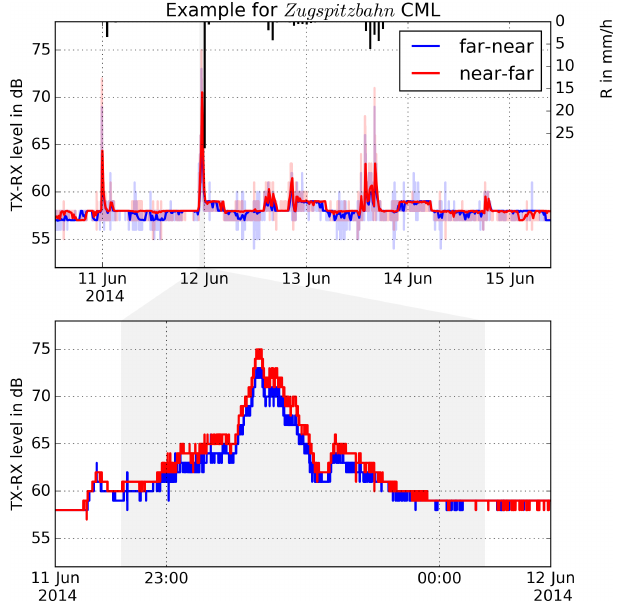
Figure 4. Example data record of a Ceragon IPMax CML used for the intranet connection between summit and valley stations of an alpine ski resort. The CML has a length of 4.7km and uses frequen- cies of 22.022 and 23.033GHz for the two directions. Top: the solid lines show the 15min averages of the TX-RX level (transmitted mi- nus received signal level). The lines with the lighter color show the raw data with 1s resolution. In addition, hourly rain rates from a DWD rain gauge in the vicinity of the CML are shown (black bars) to indicate the strong sensitivity of the CML path attenuation to rain rate. Bottom: zoomed-in version of the plot above showing only the raw 1s